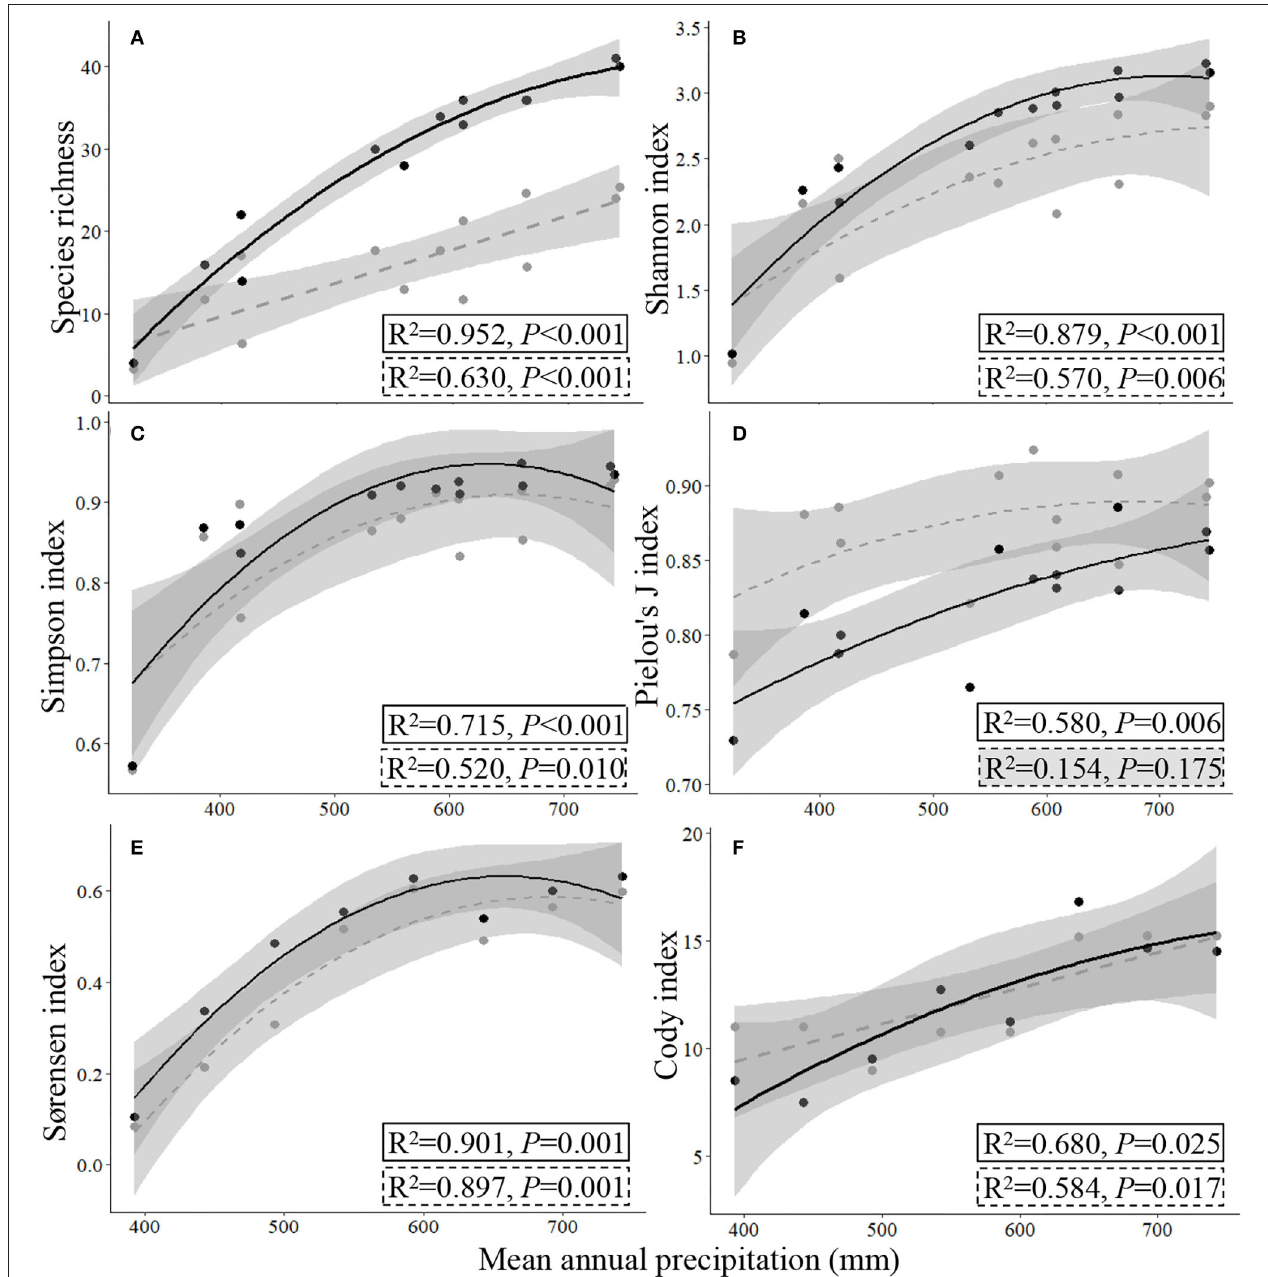
FIGURE 5 | Responses of α - (A–D) and β -diversity indices (E,F) to mean annual precipitation (2000–2017). The gray circles and dashed regression lines indicate the traditional sampling method (TSMQ), while the black circles and full regression lines indicate the presence-based sampling method (UAV B , the improved dominance-based method for A–D, UAV BD